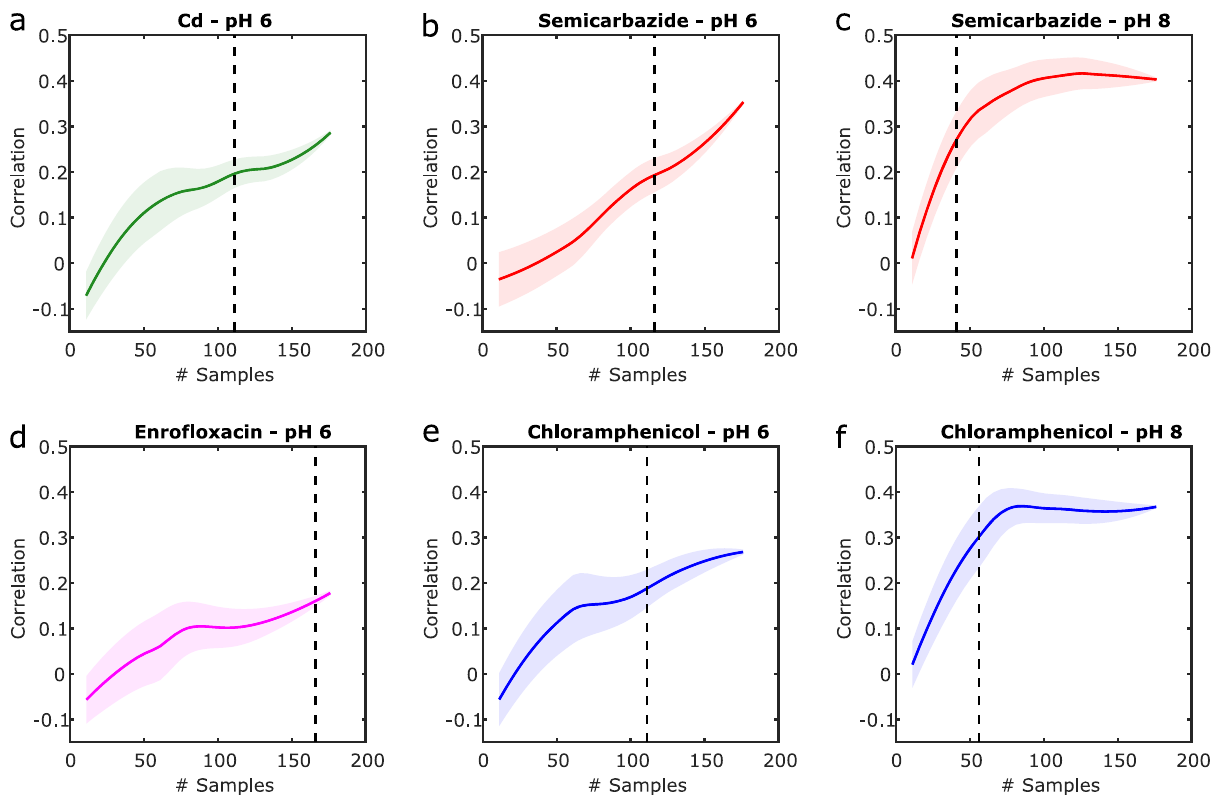
Fig. 4 Correlation between model prediction and experimental results versus sample number. The effect of sample number is shown for the 6 signi fi cant experimental conditions: a Cd - pH 6, b Semicarbazide - pH 6, c Semicarbazide - pH 8, d Enro fl oxacin - pH 6, e Chloramphenicol - pH 6, and f Chloramphenicol - pH 8. Each plot shows the average Pearson correlation coef fi cients produced by the GBDTs across random samples of size n drawn from the full database of 176 DNA-SWCNT experiments. The shaded regions show the 95% con fi dence interval for the average correlation coef fi cient for each value of n . Dashed lines show the sample size when statistical signi fi cance of p < 0.05 was reached for each experimental